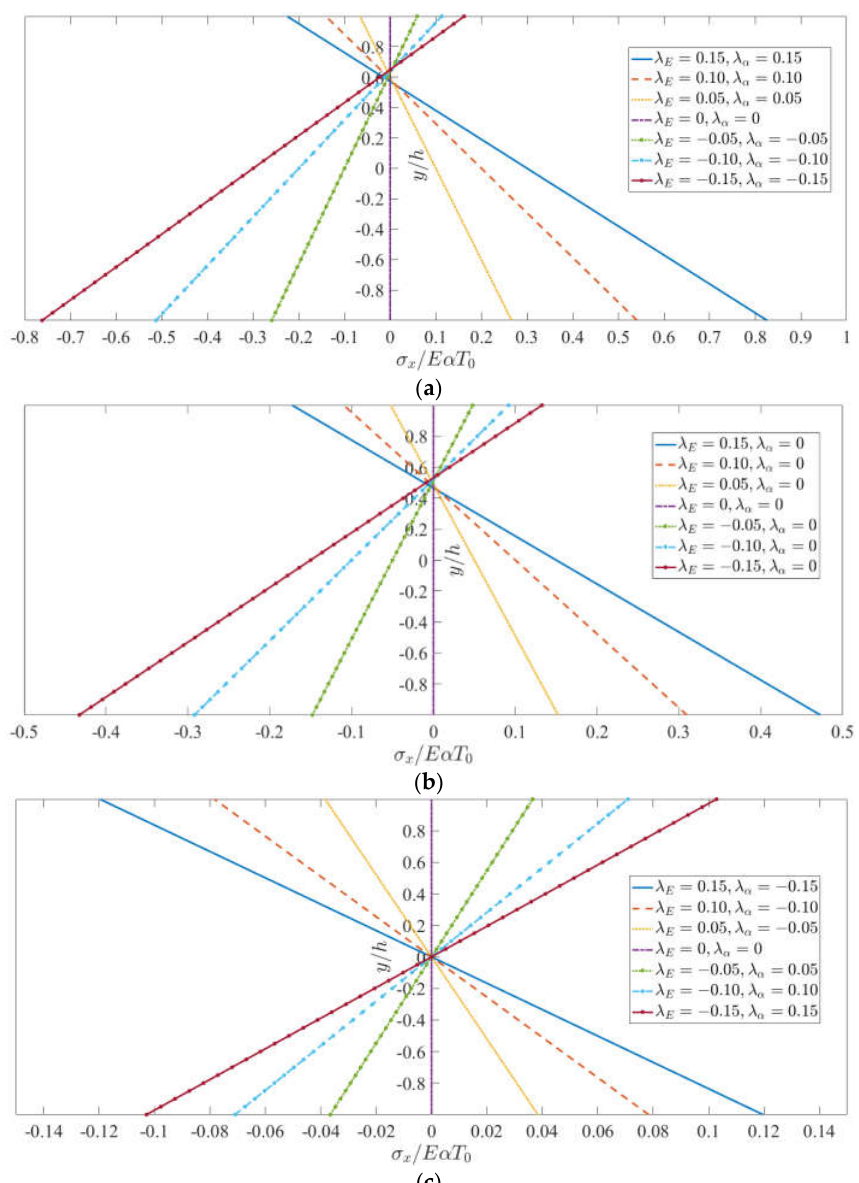
Figure 5. Thermal stresses of Case 1: ( a ) when the variation trend of λ E and λ α is consistent, ( b ) when λ α = 0 and ( c ) when the variation trend of λ E and λ α is the opposite.